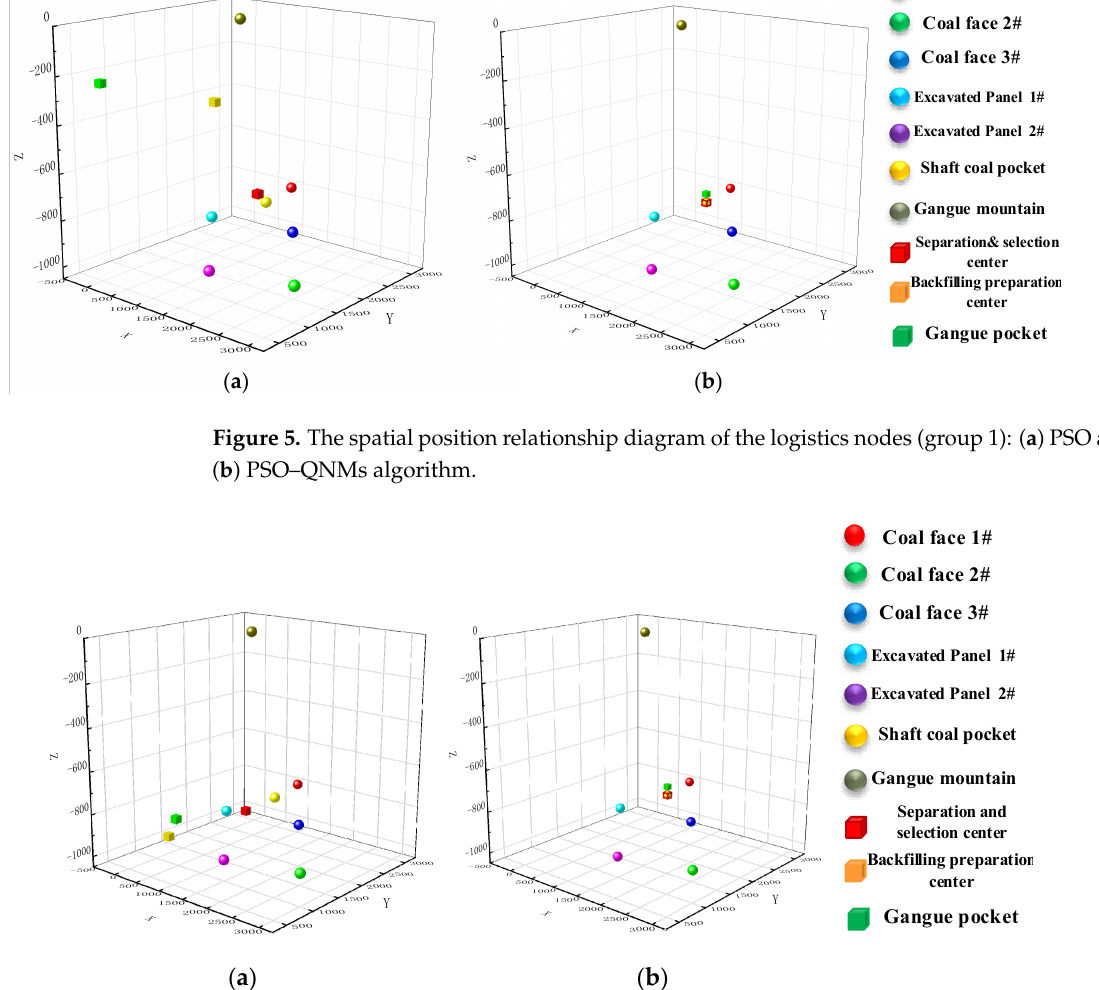
Figure 5. The spatial position relationship diagram of the logistics nodes (group 1) 5